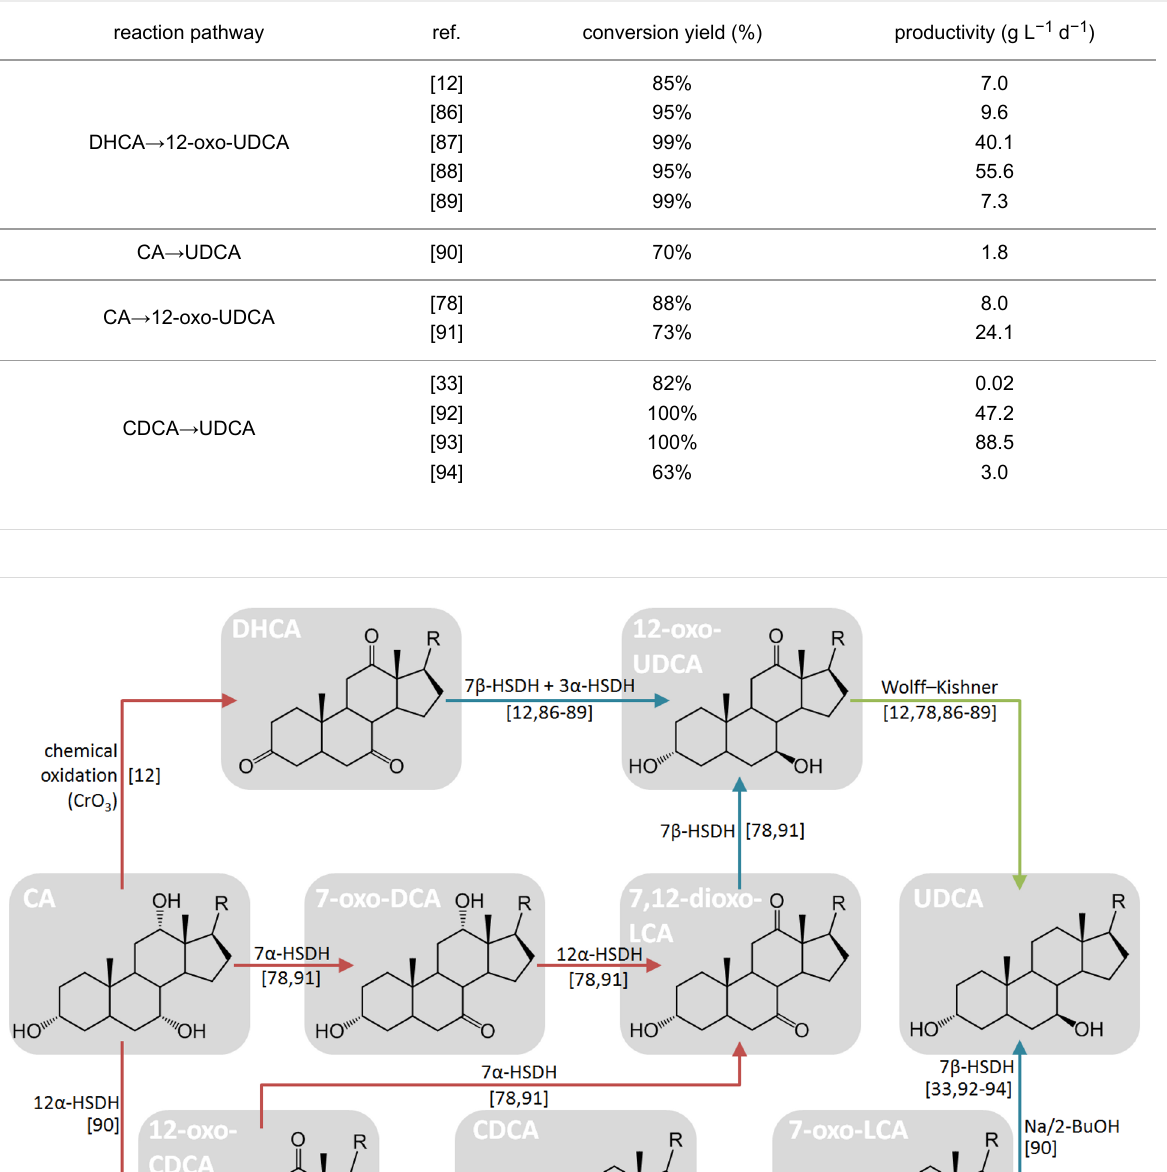
Table 5: Summary of reported chemoenzymatic transformations with purified enzymes.